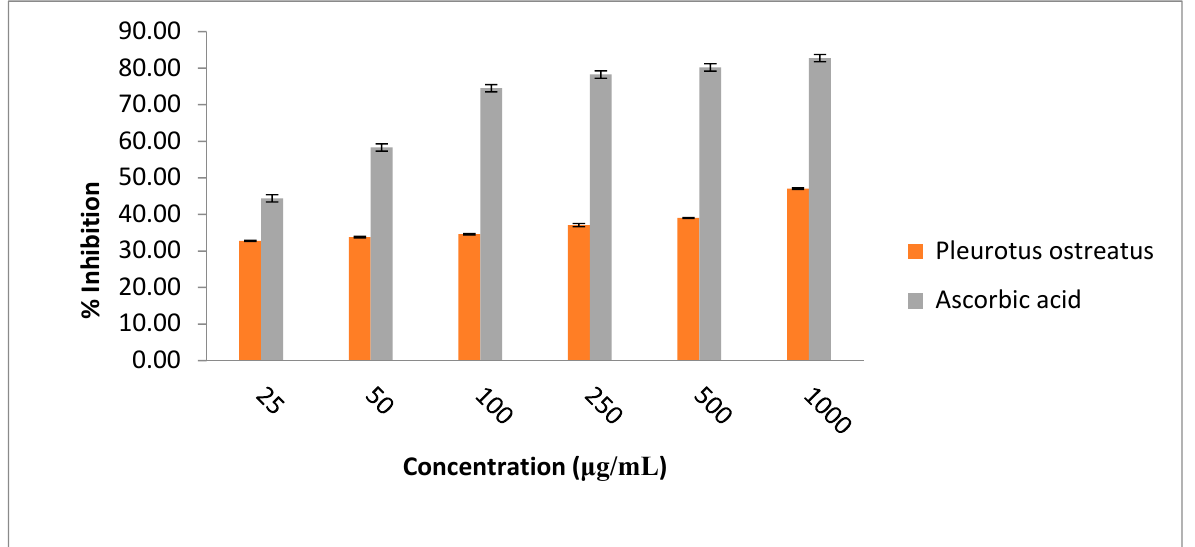
Figure 4. Concentration-dependent DPPH scavenging activities of ethanolic extract of Pleurotus ostreatus . Ascorbic acid used as reference.